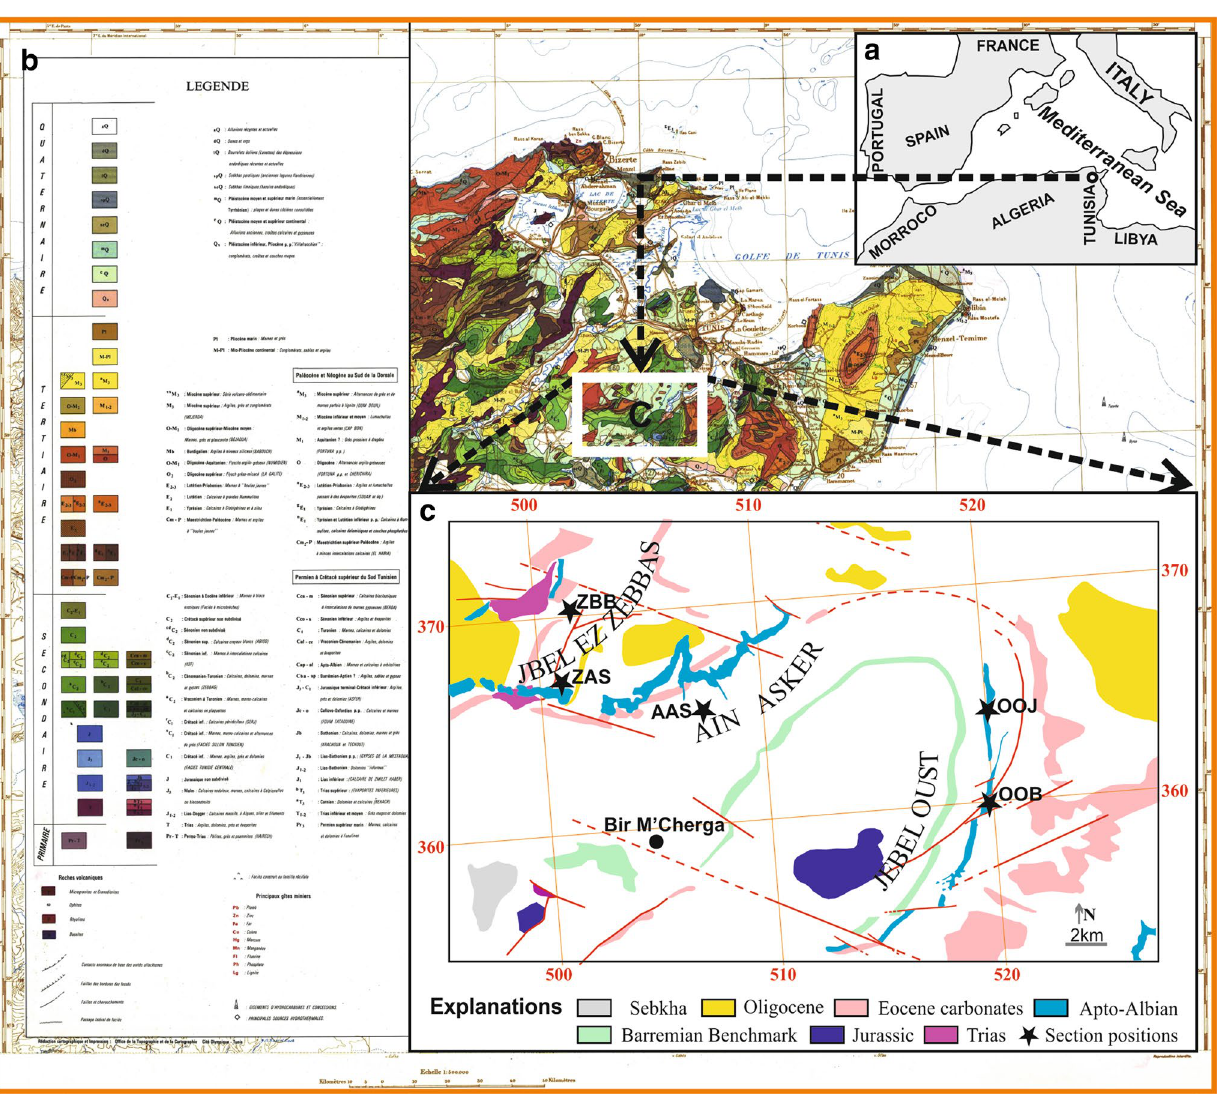
Fig. 1 a Geographic regional situation; b north-east Tunisian geologic map and c simplified geologic map of study area (Bir M’Chergua) show- ing section locations (Corel Draw figure exported into jpeg